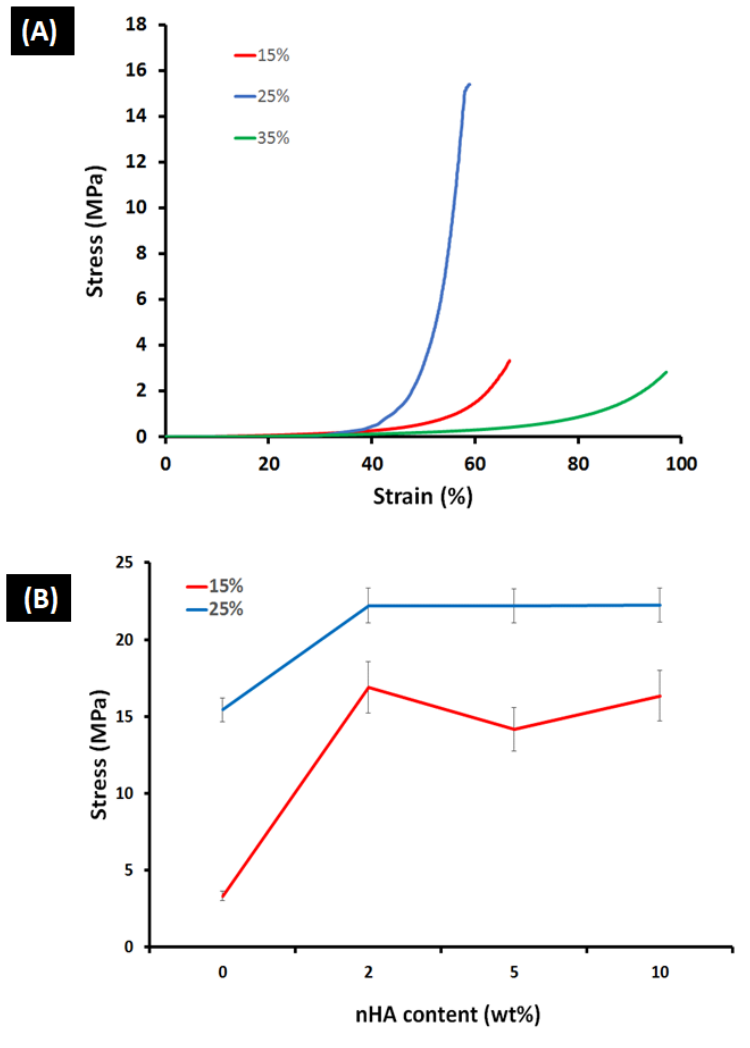
Figure 4. ( A ) Stress–strain compressive strength of the prepared GA/chitosan (15%, 25%, and 35% of the used acrylic acid) hydrogels. ( B ) Stress of 15% and 25% hydrogels as function of nHA content (0, 2, 5, and 10%, respectively) .